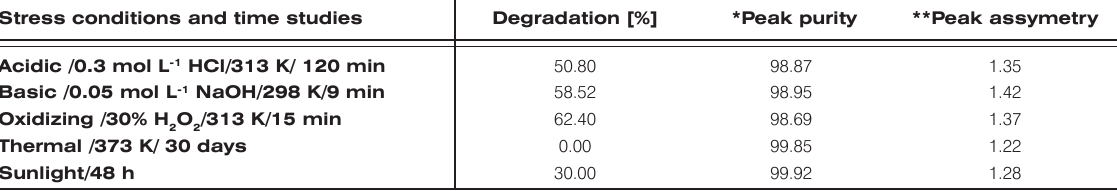
Table 4. Results of forced degradation studies.